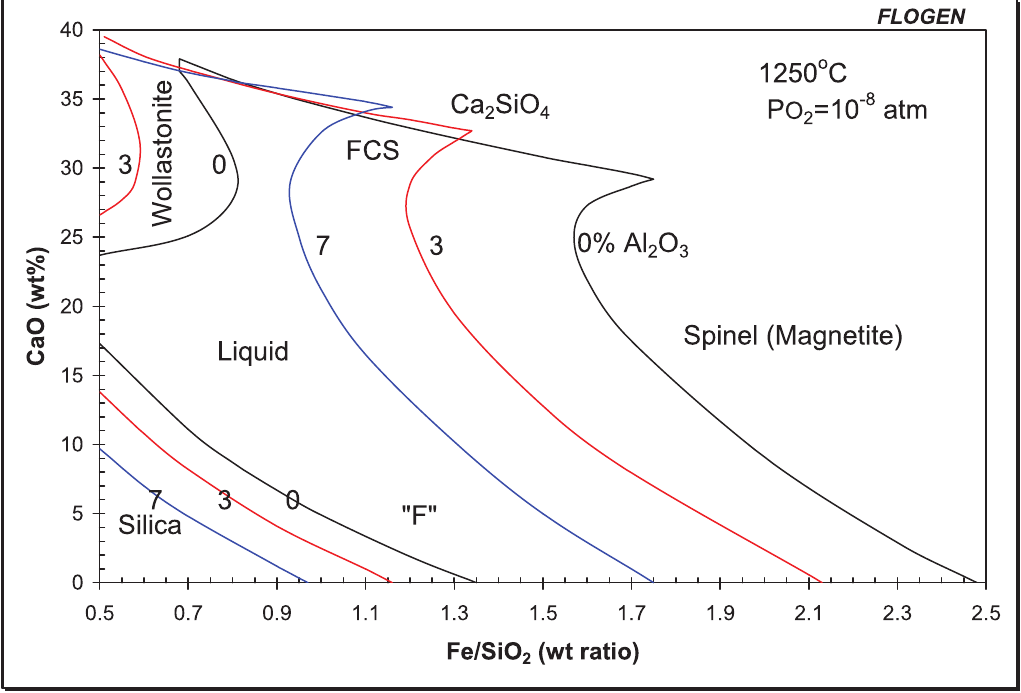
Figure 7. Liquid regions of “fayalite” (“F”) and ferrous calcium silicate (“FCS”) in the system CaO-FeO-Fe 2 O 3 -SiO 2 - Al 2 O 3 slag at 0, 3 and 7 wt% Al 2 O 3 , 1250°C and P O